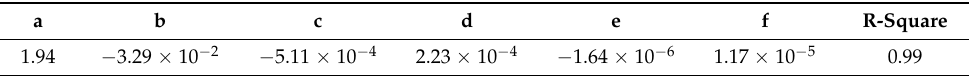
and the particle